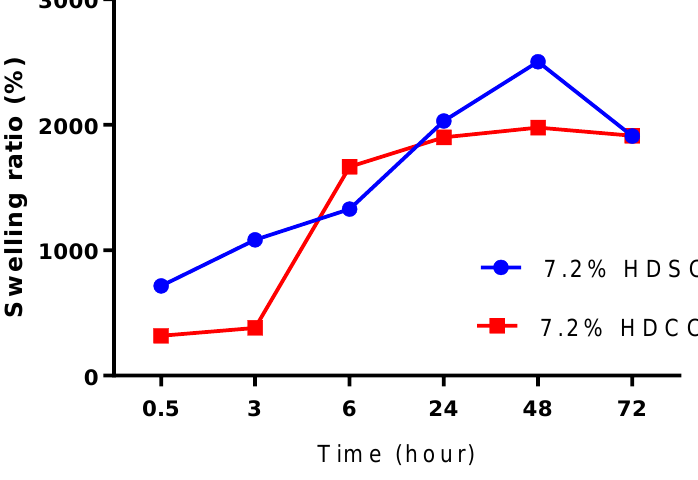
Figure 3. Degree of swelling of 7.2% HDSC and 7.2% HDCC for a period of 72 h.